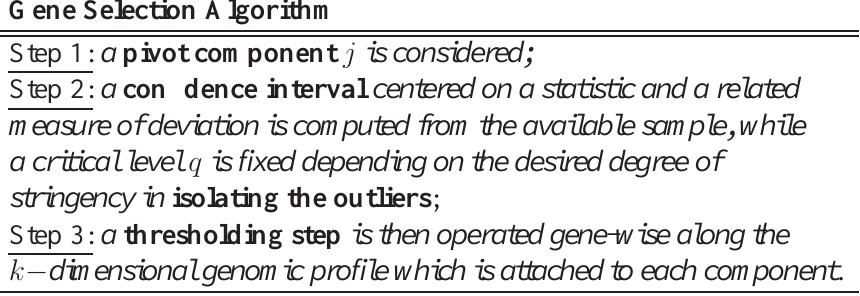
Table 1: Example of shrinkage-based gene